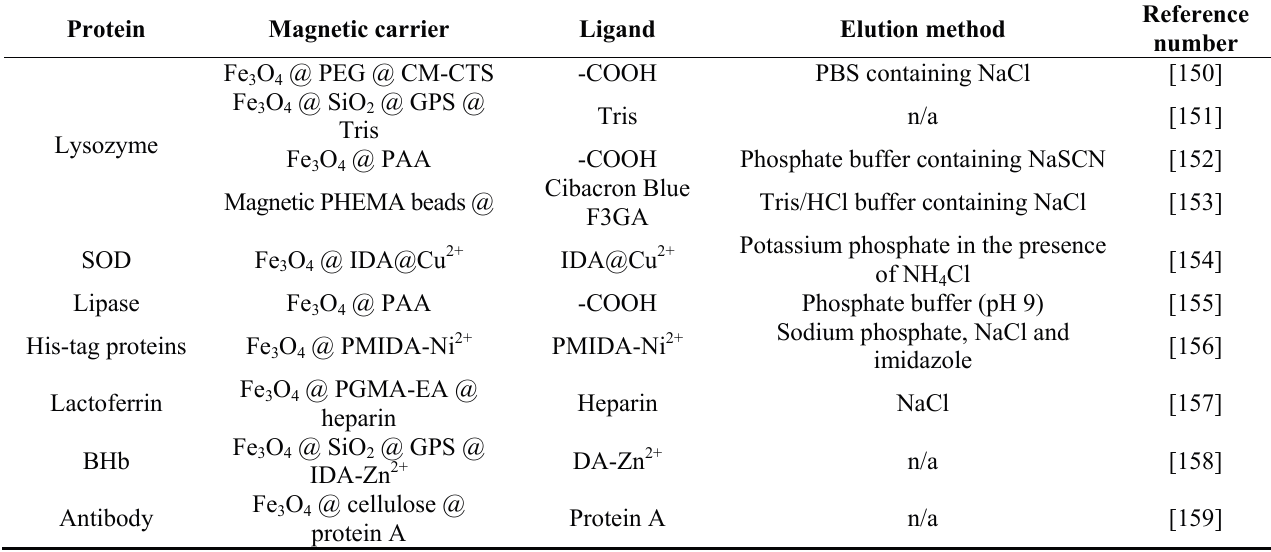
Table 2. Examples of proteins separated by modified magnetic techniques